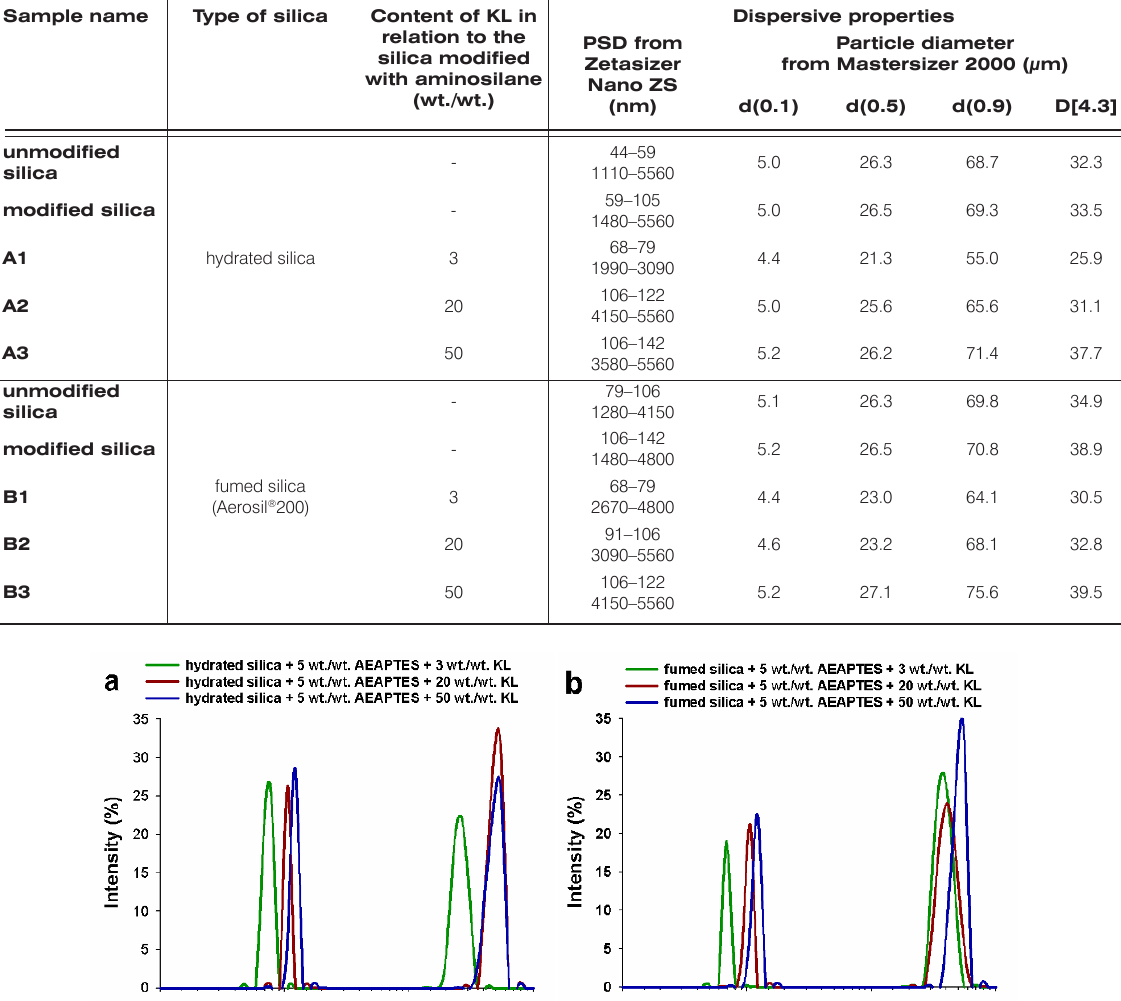
Table 1. Dispersive data for both unmodified and silane–functionalised silicas and for silica/lignin hybrid